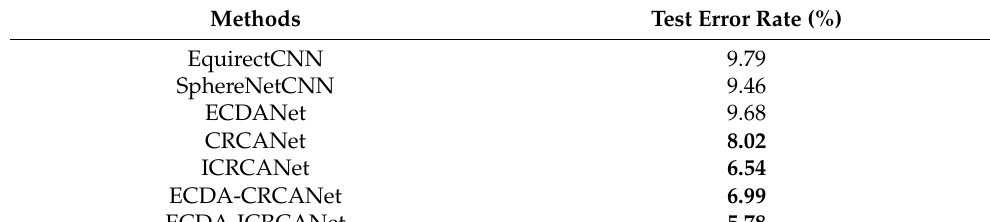
Table 2. Classification error rates of the different models on Omni-MNIST.